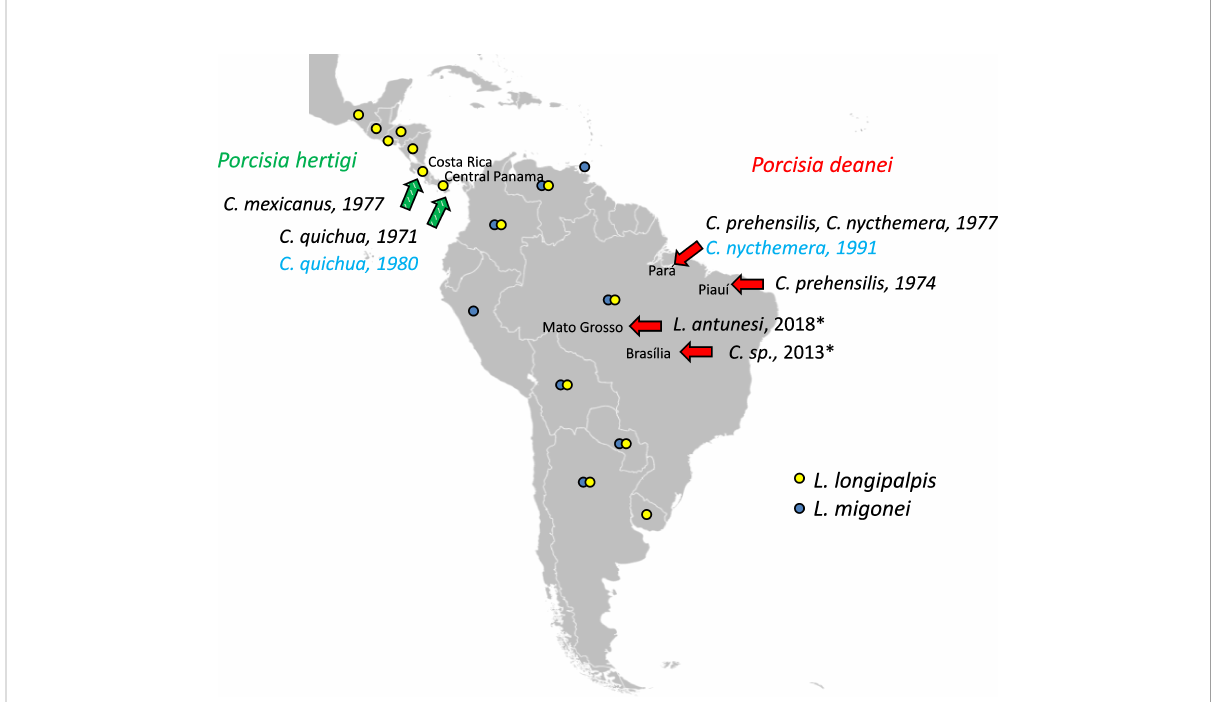
FIGURE 1 Locations of Porcisia reports. Green arrows indicate P. hertigi records and red arrows P. deanei records with publication/isolation dates and host species, based on (Herrer, 1971; Deane et al., 1974; Zeledo ́ n et al., 1977; Lainson and Shaw, 1977; da Silva et al., 2013). Asterisks indicate two Porcisia records identi fi ed as P. hertigi , but the species identi fi cation method was not suf fi cient to distinguish the two Porcisia species, and based on geographic region and host species, both are P. deanei (Espinosa et al., 2016). Strains used in this study are indicated in blue. Countries with records of L. longipalpis and L. migonei according to Shimabukuro et al., 2017 are marked with yellow and blue circles, respectively. The blank map source –